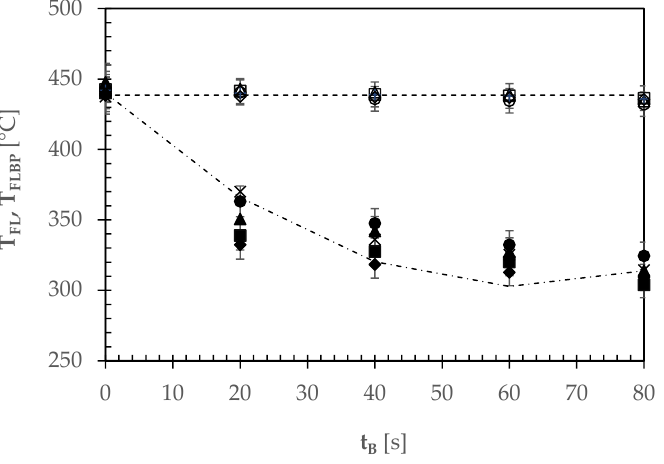
Figure 3. Time course of the average temperatures of the oven floor as exposed to fire (T FL : open and + symbols) or shielded by the pizza sample (T FLbp : closed and × symbols) throughout the baking tests of different pizza types: A, , • ; B, (cid:52) , (cid:78) ; C, (cid:3) , (cid:4) ; D, ♦ , (cid:7) ; E, +, × . The horizontal broken line shows the average temperature of the oven floor around any pizza undergoing baking, while the dash-dotted line shows the quadratic regression line used to simulate the temperature profile of the oven floor under a tomato pizza (C).